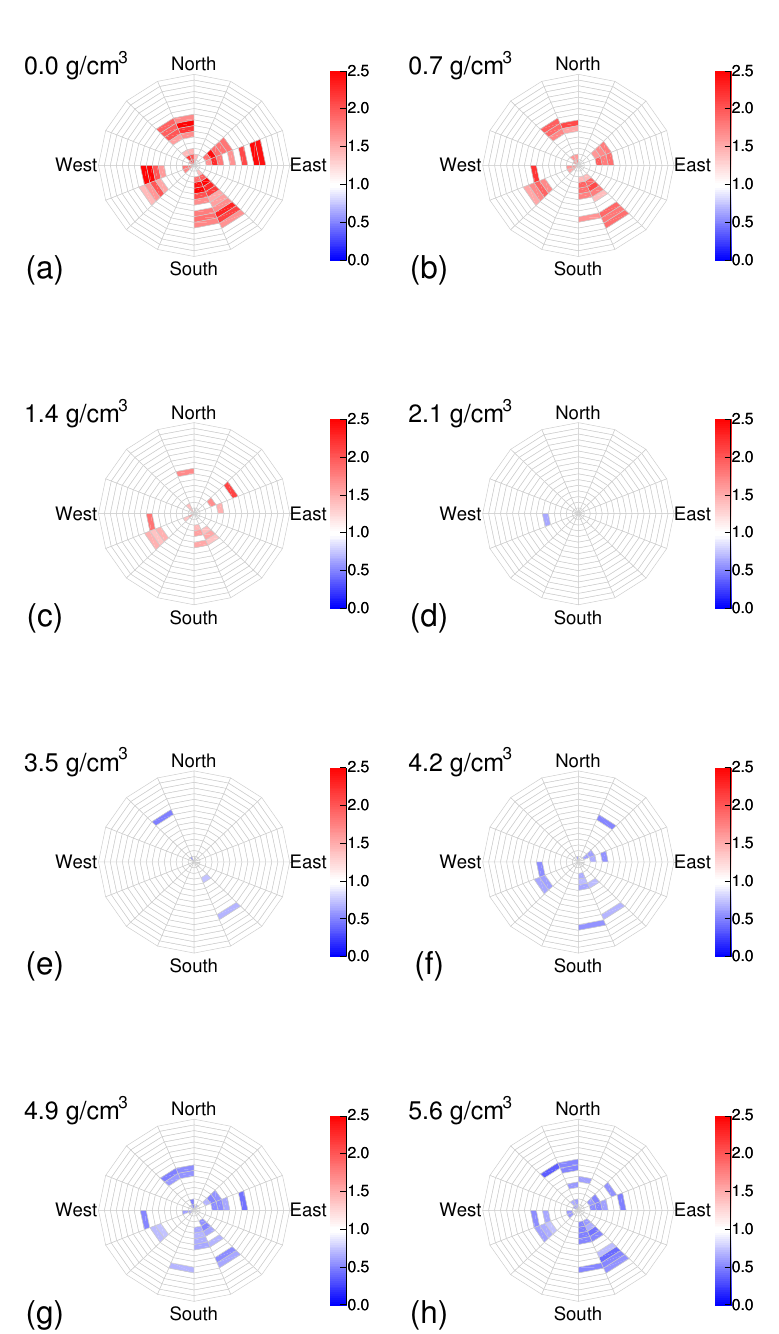
Figure 7. The ratio radar images of the density variation regions, assuming a six-month data acquisition with the detector placed inside the mountain. The radial dimension is the cos θ zen of the muon direction; the innermost point and the outermost circle correspond to cos θ zen = 1 (vertical upward direction) and cos θ zen = 0.2, respectively. We do not draw the regions with a cos θ zen < 0.2, in which the MT is not sensitive due to the low event rate. The densities of ( a – h ) are 0, 0.7, 1.4, 2.1, 3.5, 4.2, 4.9, and 5.6 g/cm 3 , respectively. The color shows the ratio r of the number of muons passing through the mountain with the density variation regions to the number of muons passing through the reference mountain. The division is weighted according to the data acquisition time. We set the r of the bins with a statistical significance < 3 σ to 1, which means no difference from the reference one, when plotting. The ratio uncertainty r unc of the colored bins satisfies r unc ≤ | r − 1 |